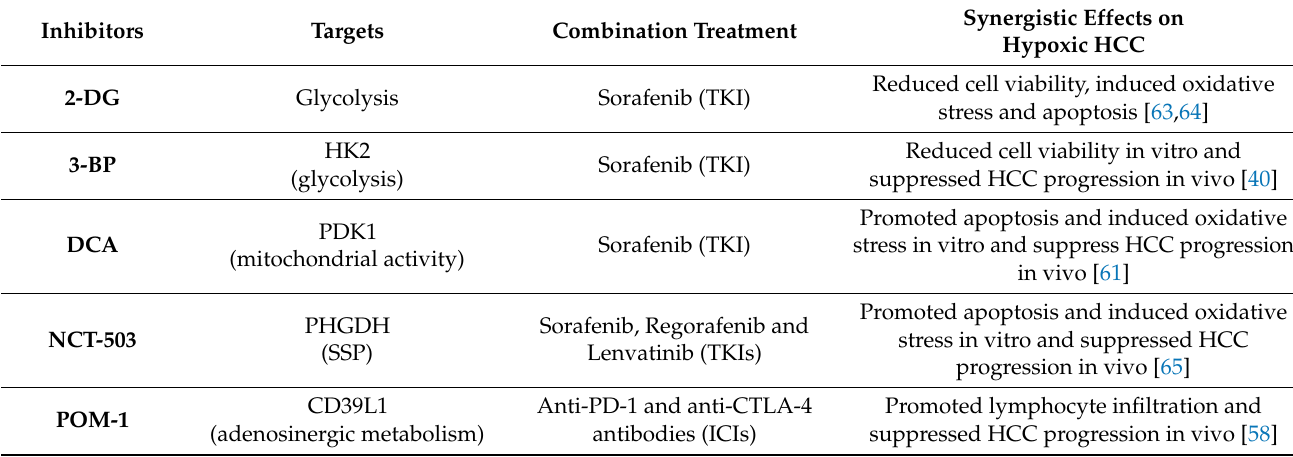
Table 2. Combination treatments of inhibitors targeting genes in metabolic pathways altered by HIFs with TKIs or ICIs to overcome drug resistance in hypoxic